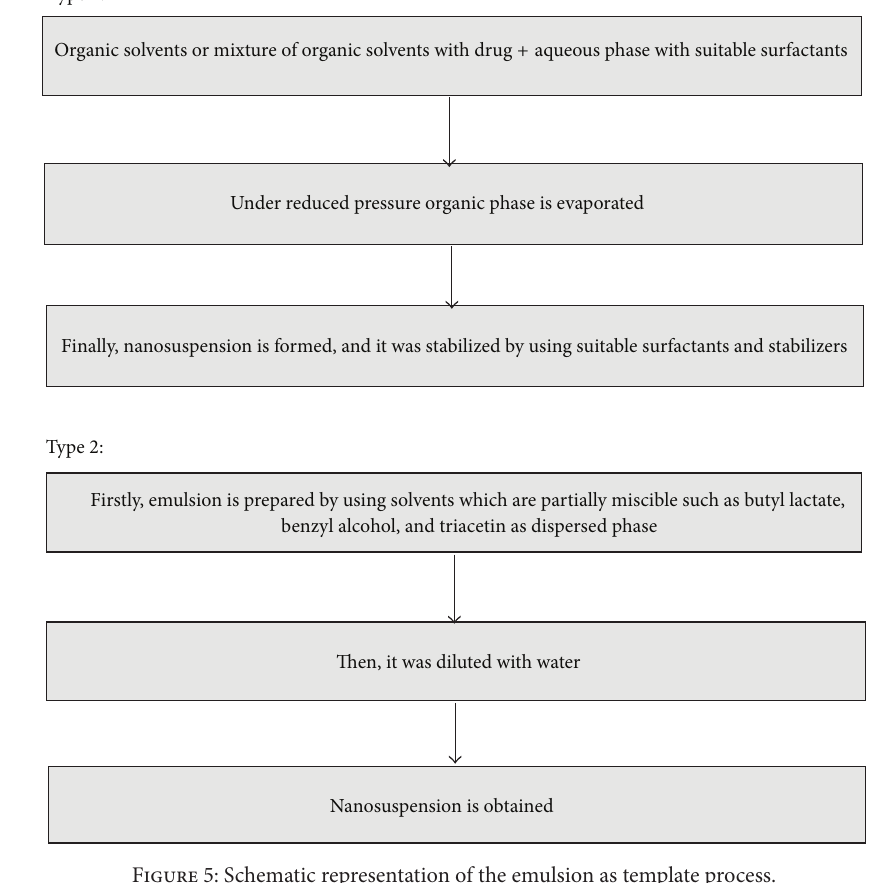
Figure 5: Schematic representation of the emulsion as template process.